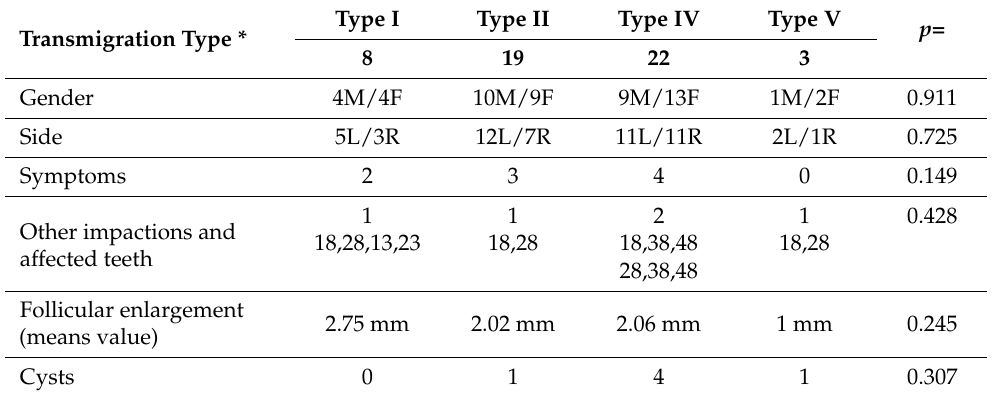
Table 1. Symptom Clinical and radiological